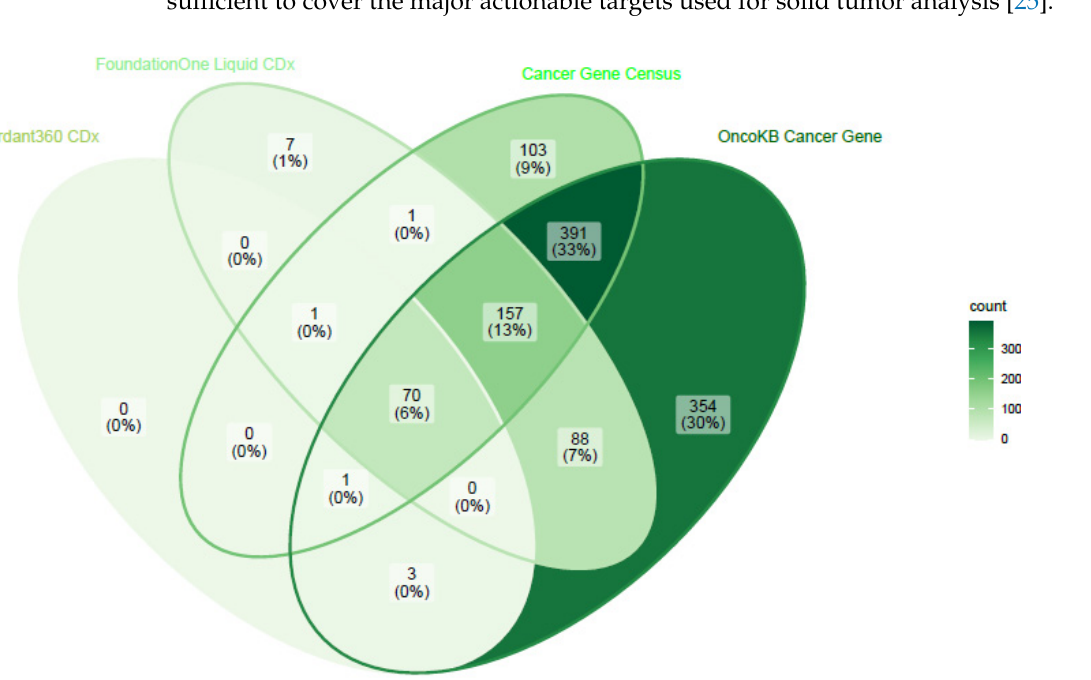
Figure 1. Venn diagram representing overlap of genes studied for SNV in two FDA-approved panels and two commonly used reference gene lists. and two commonly used reference gene